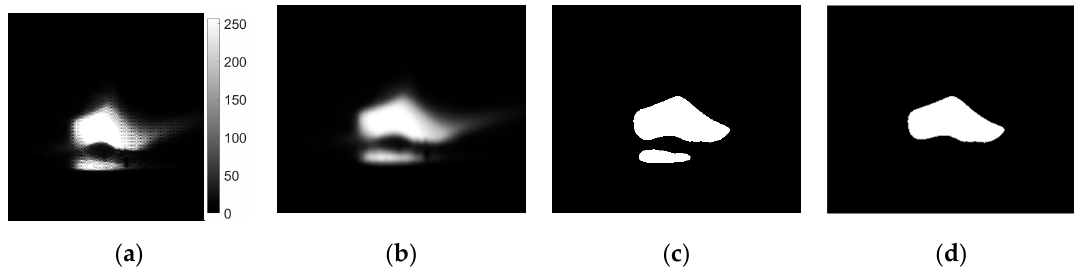
Figure 6. Processing steps of visible light camera (VIS CAM) images: ( a ) original image—arc luminance; ( b ) low-pass filtered image—arc luminance; ( c ) binarized image; ( d ) binarized image with only the arc region of interest (ROI) remain- ing.